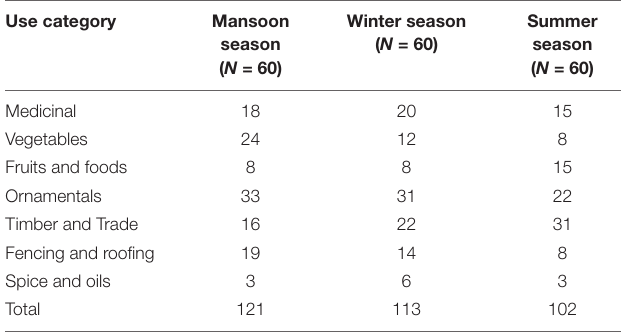
TABLE 5 | Season-wise (monsoon, winter, and summer) distribution of total plant species in different use categories in the home gardens of the selected villages. Use